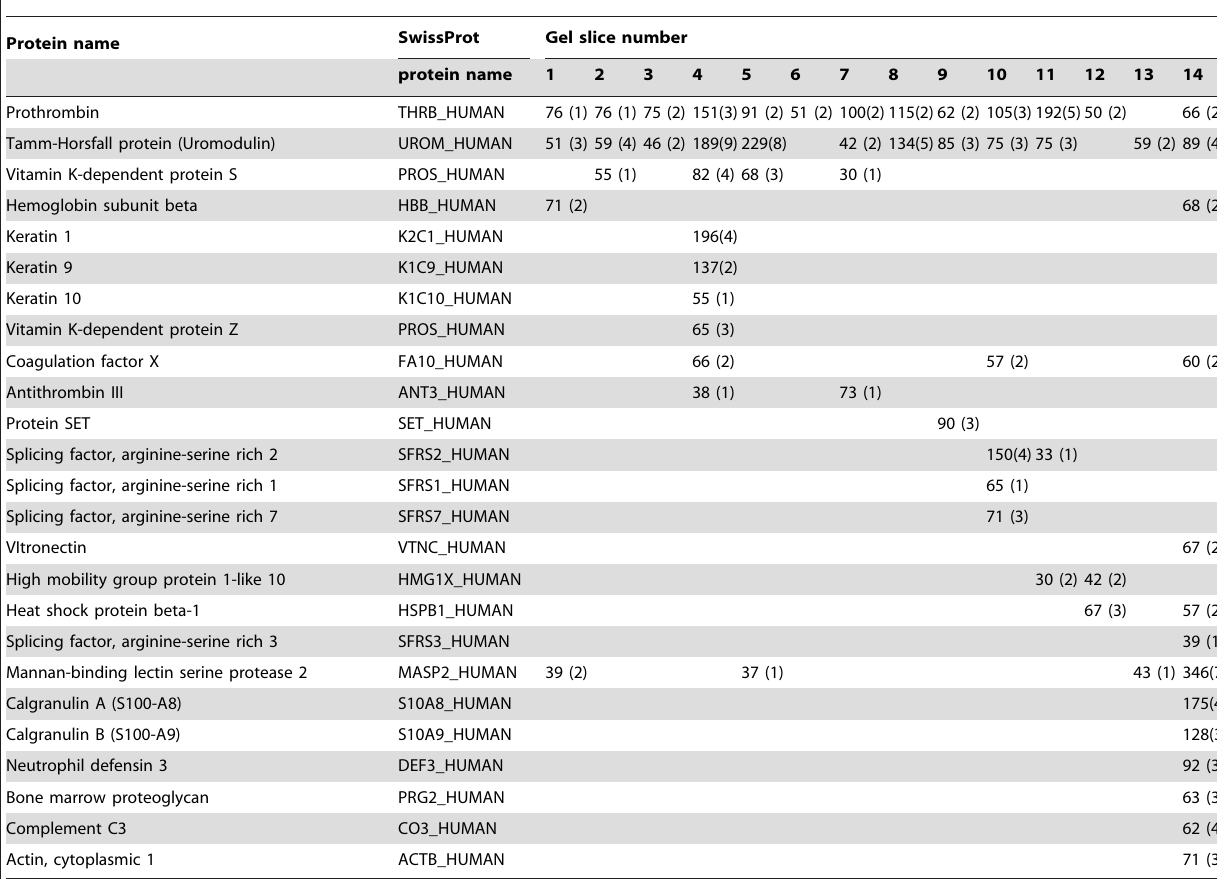
Table 2. Example of protein distribution in SDS-polyacrylamide